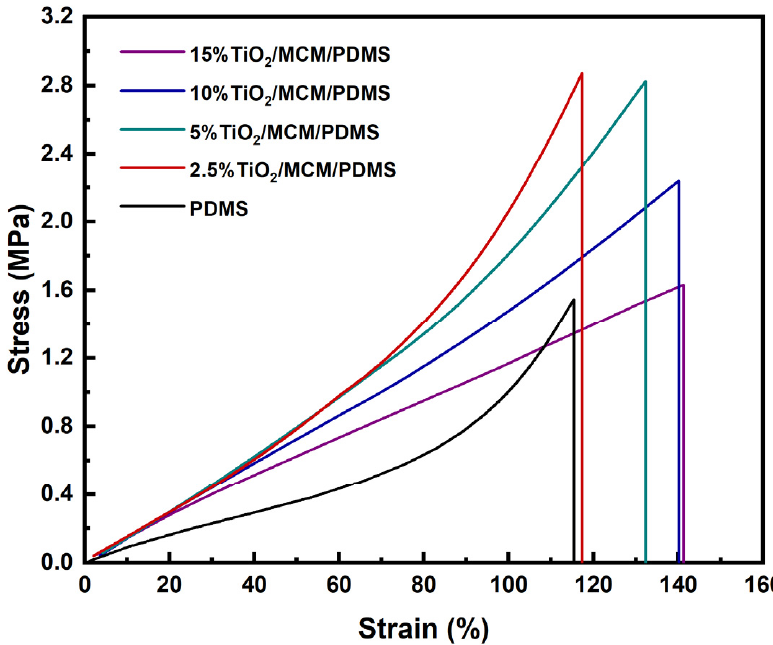
Figure 3. The stress–strain curves of TiO 2 /MCM/PDMS composites at various TiO 2 /MCM wt%. The tensile stress–strain curves show a higher elongation at break with the addition of a filler, and a maximum value of 150 MPa for the toughness of 10 wt% TiO 2 /MCM reactive adsorbent was obtained, as compared to a value of 62 MPa for the pristine PDMS. The toughness further decreases as the TiO 2 /MCM content increases from 10 wt% to 15 wt%. The characteristic nonlinear strain-hardening effect disappears in the plastic region of the composite after the addition of a >5 wt% filler. This effect is due to the filler–matrix interactions limiting the chains’